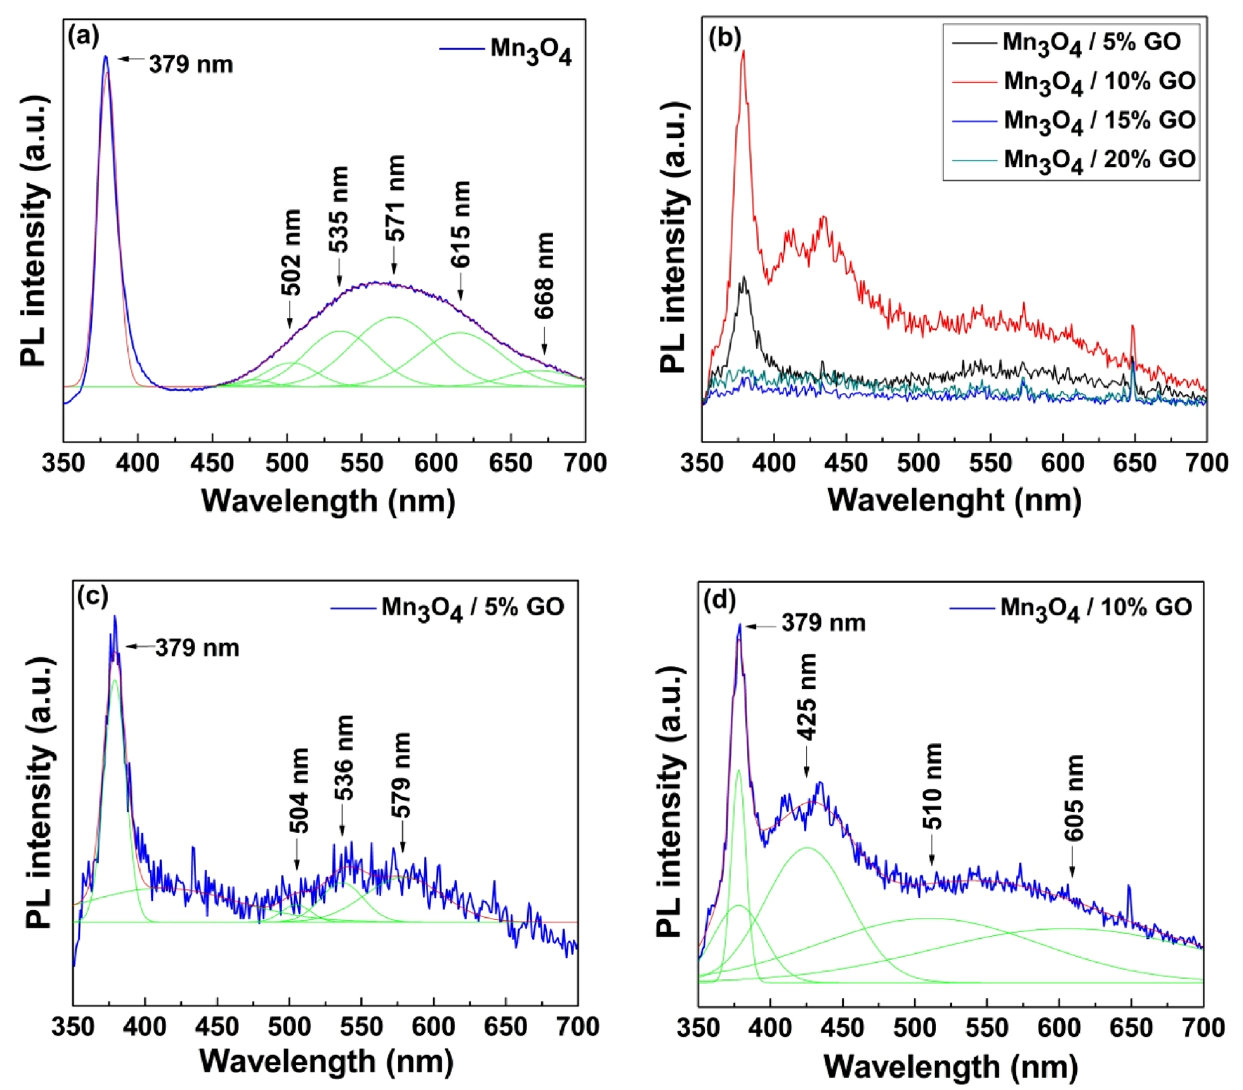
Fig. 7 Photoluminescence spectra of a Mn Mn O /5%GO NC’s and d PL spectra for the Mn 3 4